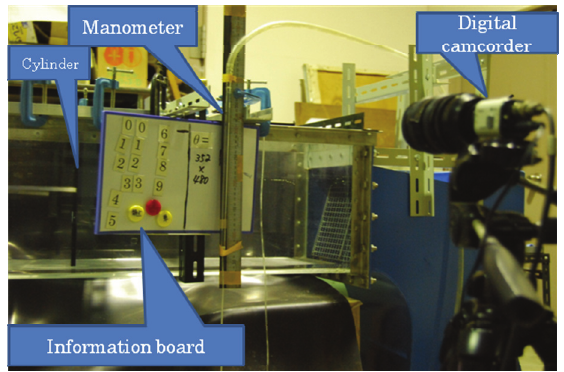
Fig. 3. The test section and single tube manometer of the closed circuit water channel apparatus, and digital camcorder